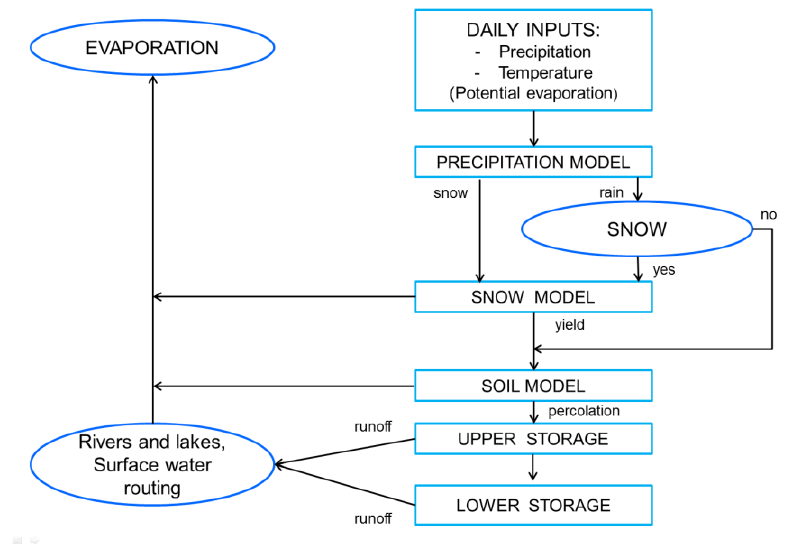
Figure 3. The schematic figure of the hydrological model used in Finland based on the data presented in Figure 6 originally published in Vehviläinen & Huttunen